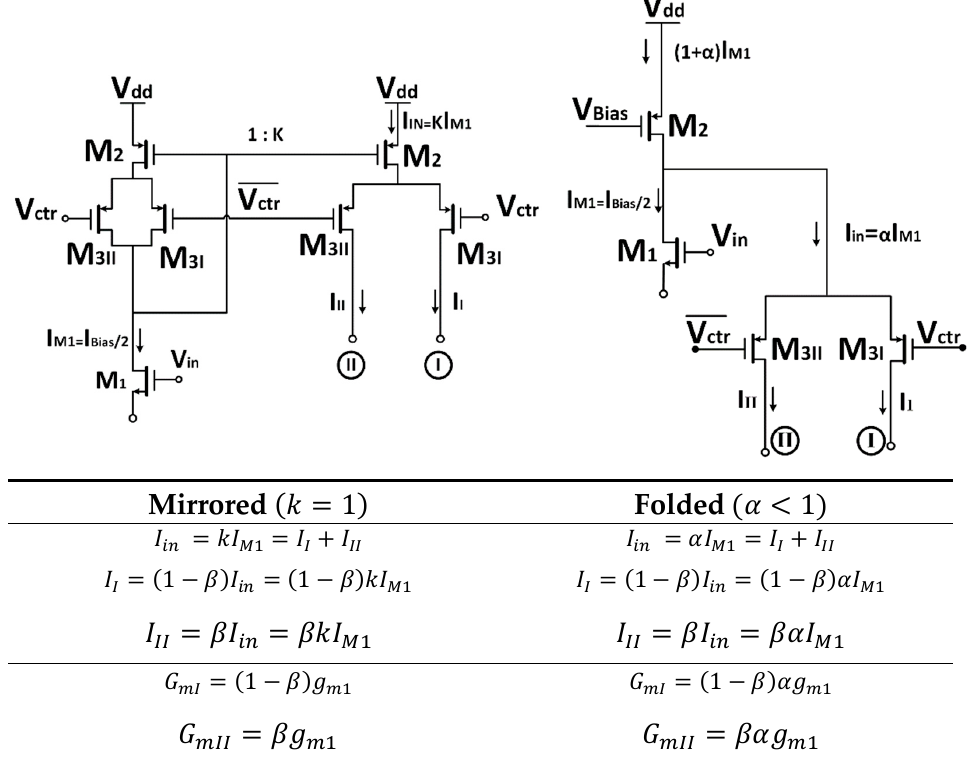
Figure 3. Current steering technique applied to ( a ) Mirrored OTA; and ( b ) Folded